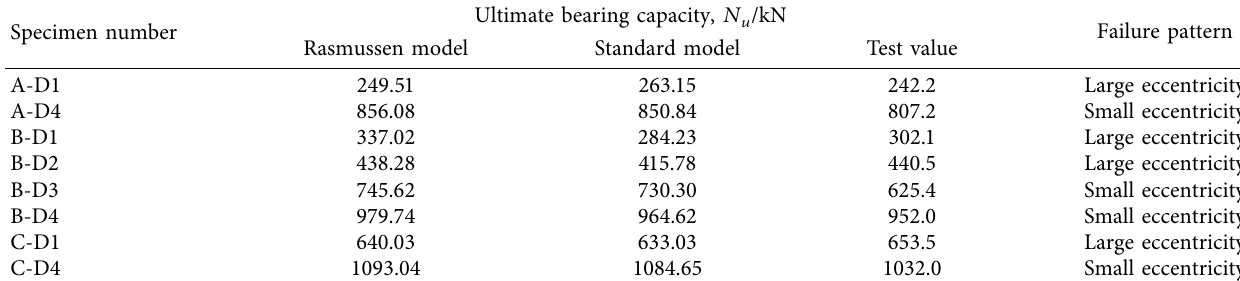
Table 6: Mechanical indexes of stainless